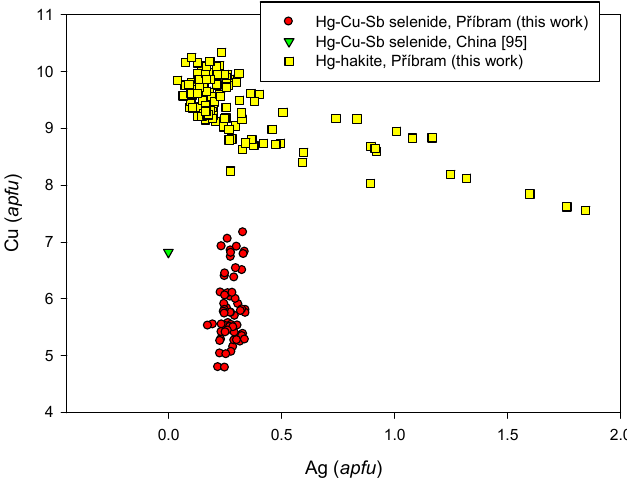
Figure 65. Ag vs. Cu ( apfu ) graph for unnamed Hg-Cu-Sb selenide and Hg-hakite.